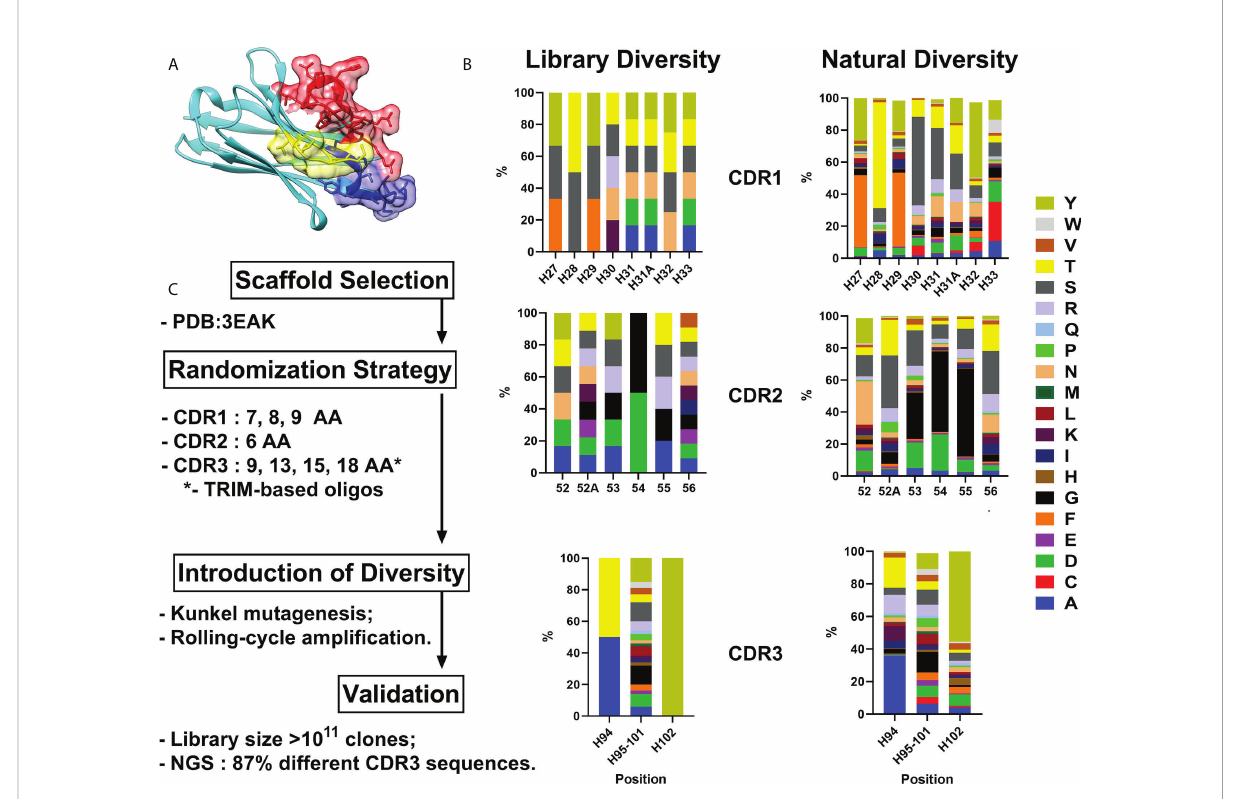
FIGURE 1 VHH library generation pipeline. Humanized VHH scaffold (A) – CDR1, CDR2 and CDR3 are depicted in blue, yellow and red respectively. (B) - Comparison between relative amino acid frequencies in CRD1, CDR2 and CDR3 observed from Camelid VHH sequences and VHH4.0_DD library. (C) – Library generation and validation scheme. Amino Acid are indicated in single letter